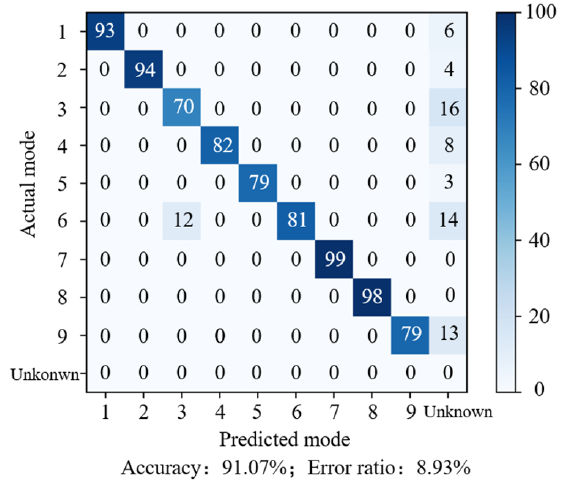
Figure 13. Confusion matrix for pattern matching.